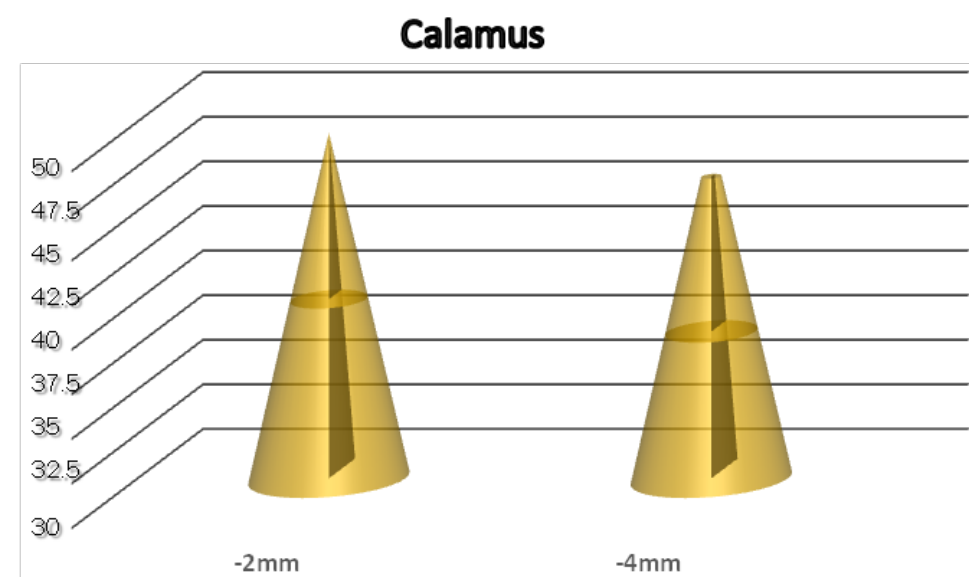
Figure 3. Average temperatures at − 2 mm and − 4 mm with Elements Free ( p = 0.01).